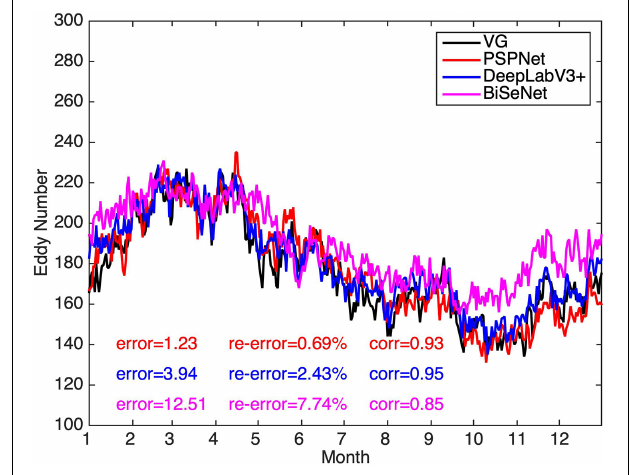
Frontiers in Marine Science |